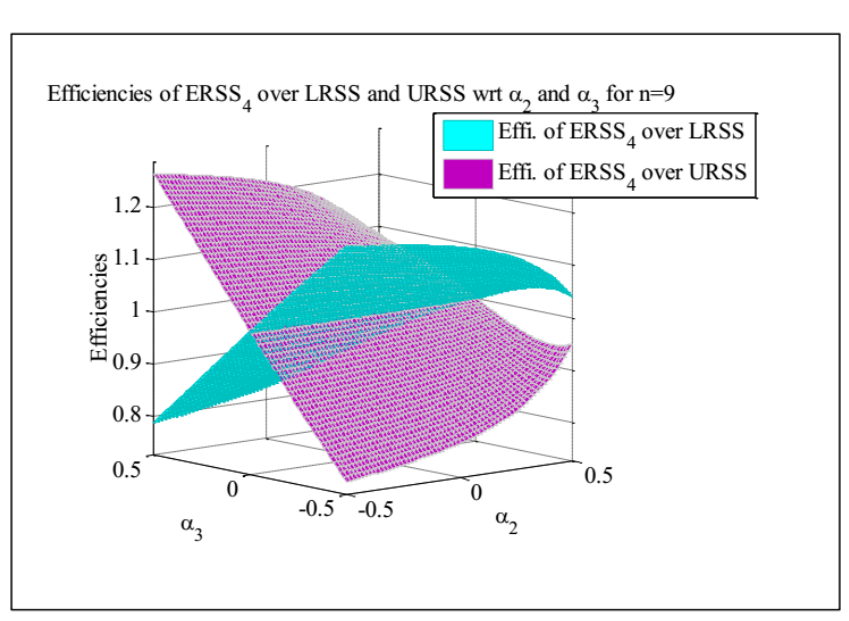
over ˆ θ and ˆ θ for n = 9. 2,ERSS 4 2,LRSS 2,URSS